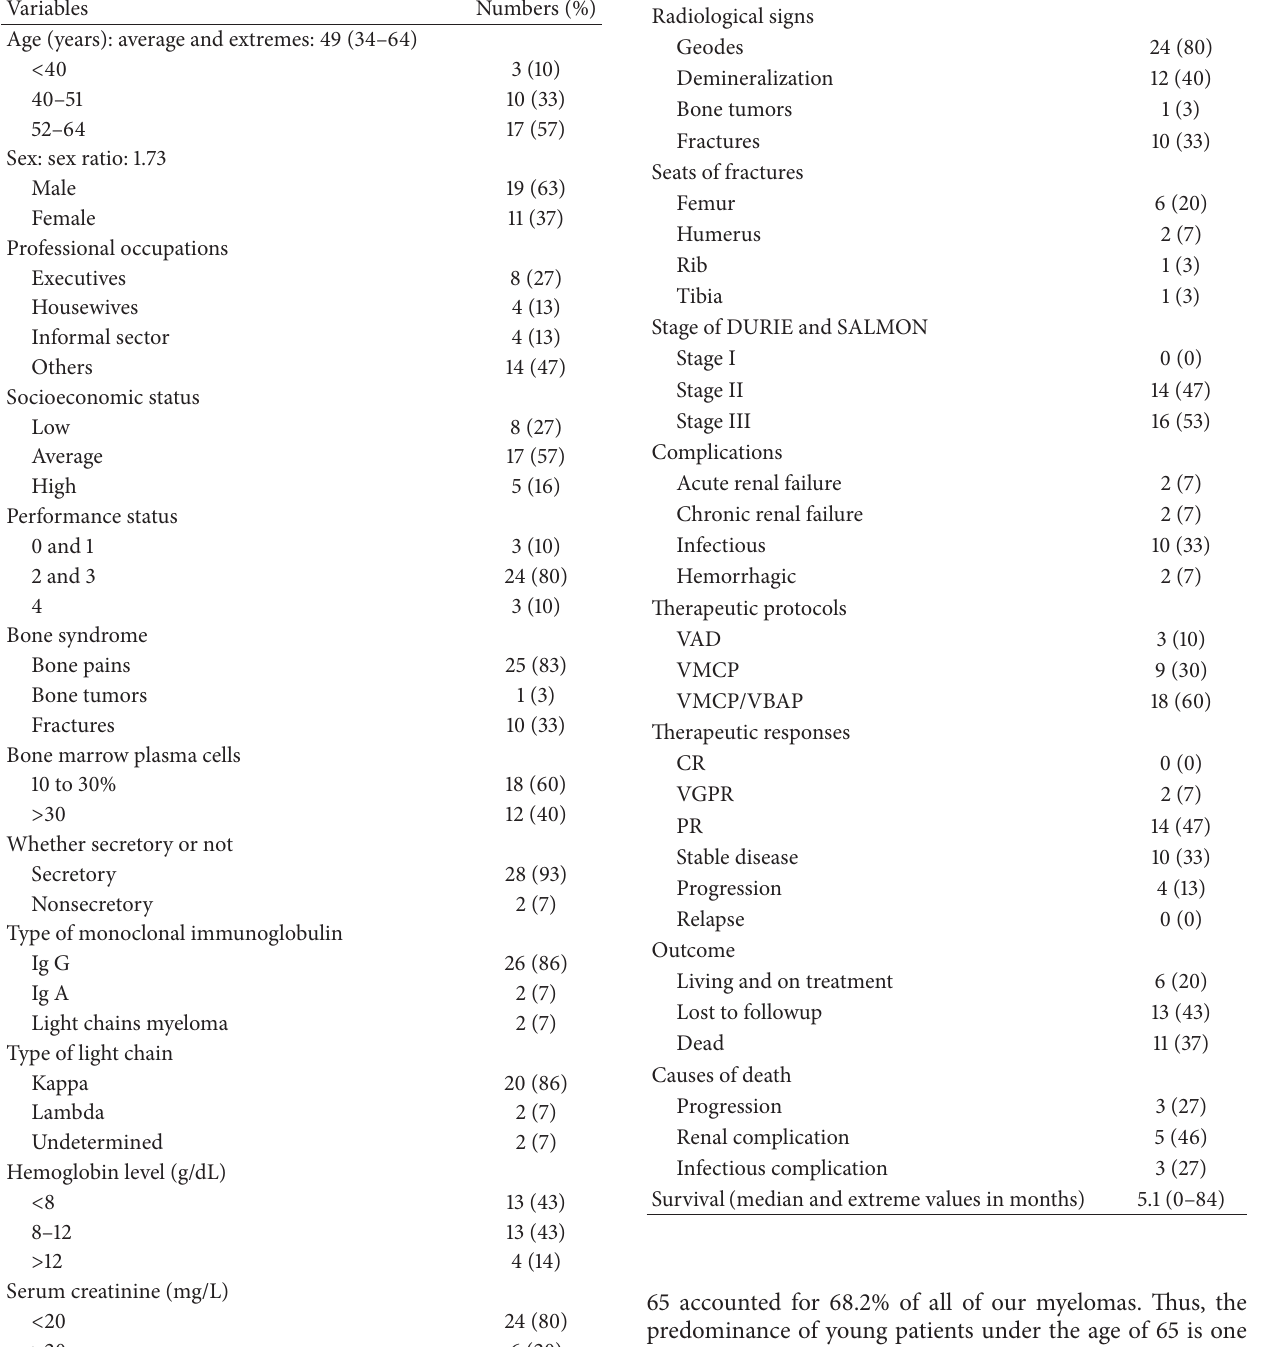
Table 2: Radiological, evolutional, and therapeutic